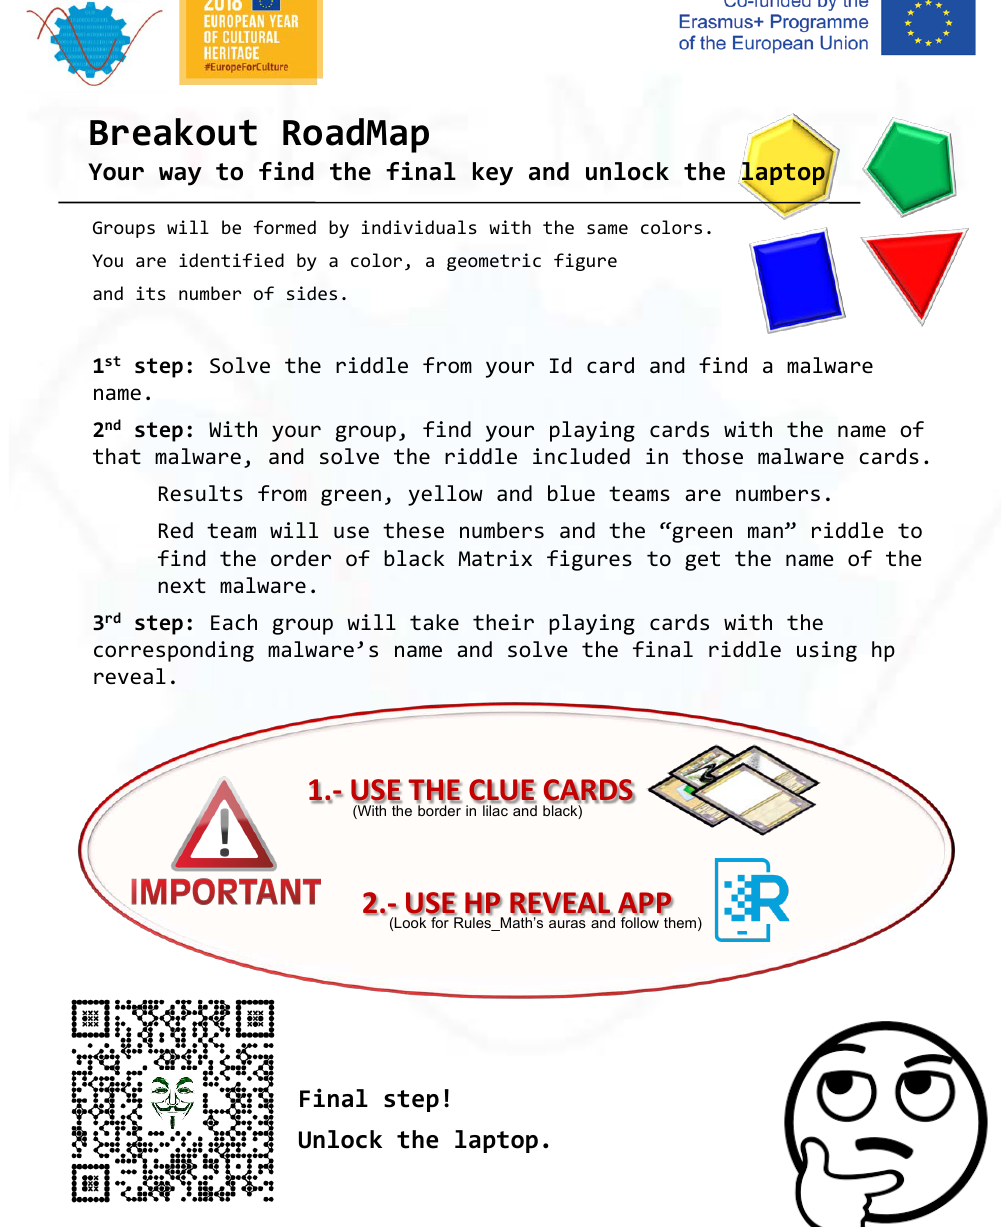
Figure 2. Road map with Breakout instructions and